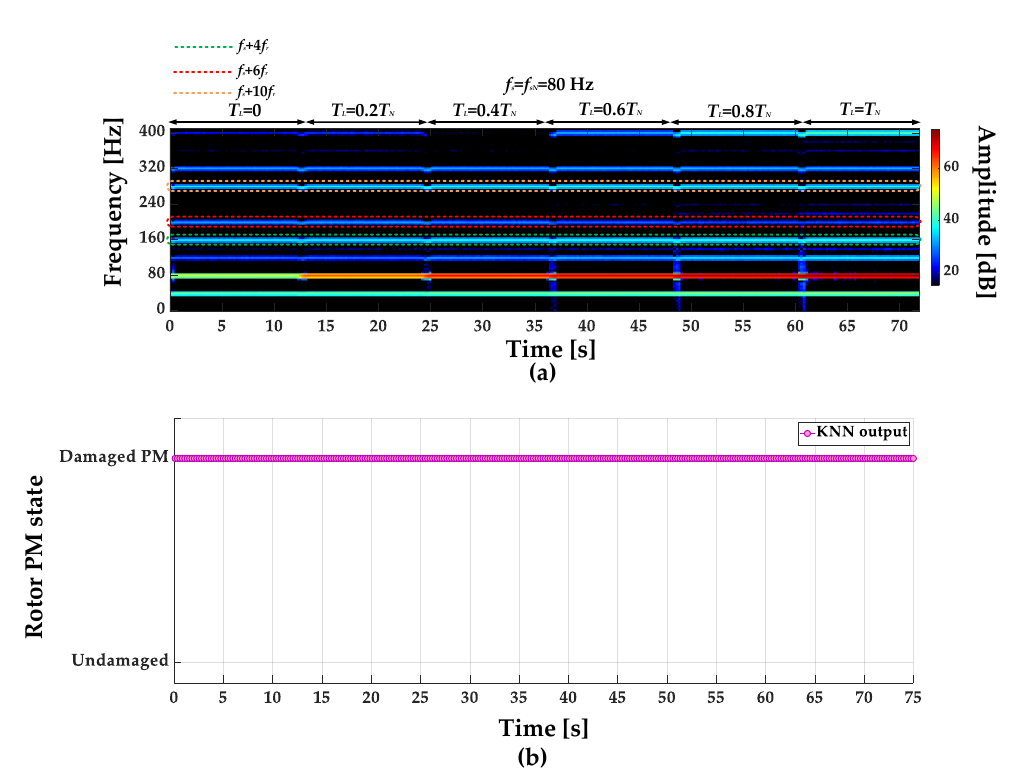
Figure 18. ( a ) Part of the stator phase current STFT spectrogram, ( b ) response of the KNN-based fault detector for damaged PM rotor ( T L = var, f s = 80 Hz).